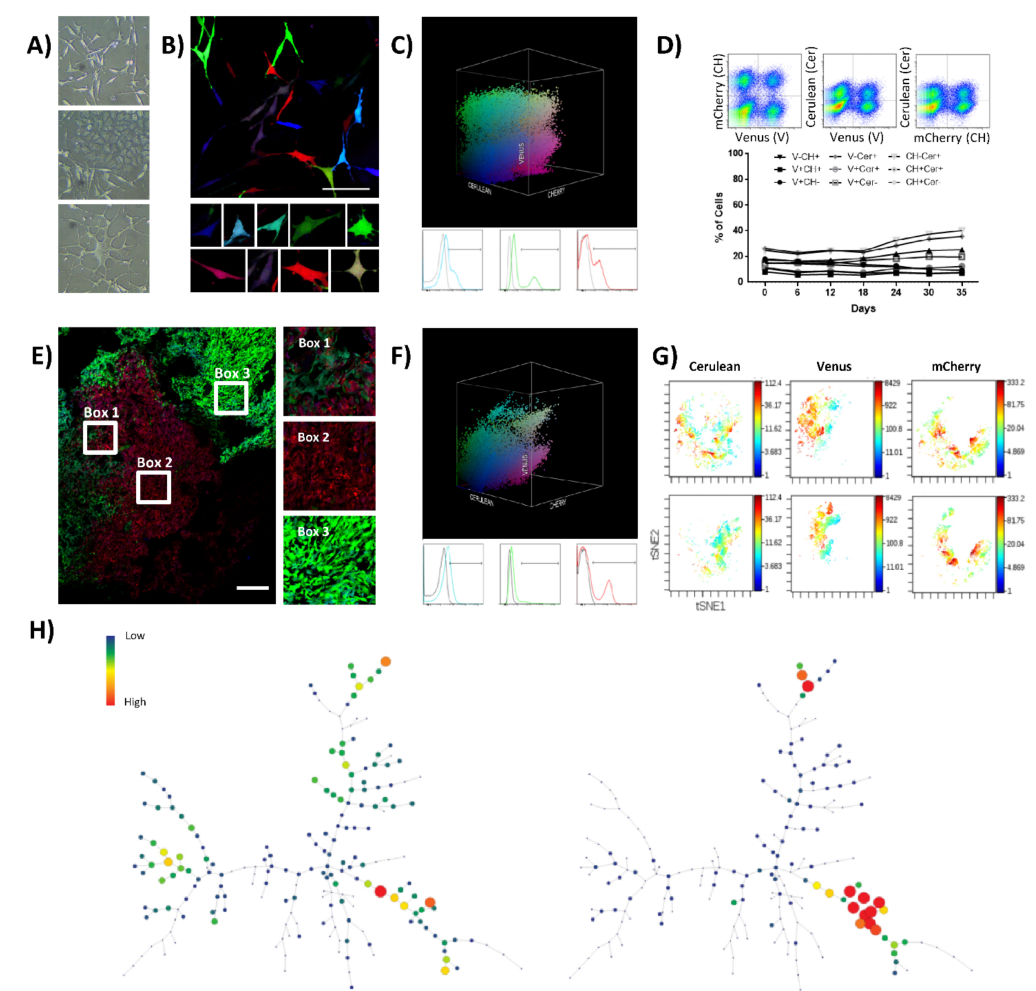
Figure 1. K5 OSA RGB cells develop oligoclonal tumors in vivo. ( A ) Phase-contrast microscopy images of K5 OSA cells; from the top to the bottom, representative images of cells with fibroblastic, tile-osteoblastic and multinucleated cell morphology during in vitro culturing. ( B ) Representative confocal microscopy images of K5-RGB cells in vitro; in the lower part, a detailed picture series of marked cells. Note that RGB-marking induces a highly variable colorimetric fluorescent marking; white bar = 100 µ m. ( C ) Three-dimensional flow cytometry plot of K5-RGB cells in vitro; the three dimensions of the 3D dot plot represent the three RGB fluorescent variants: Cerulean, Venus and mCherry. Dots are colored according to their fluorescent marker expression or their possible combinations. In the lower part, histograms showing transduced cells vs. control (un-transduced K5 OSA cells); fluorescent marker signal distribution is presented separately in blue (Cerulean), green (Venus), and red (mCherry). For detailed MOI calculation and RGB-marking optimization, see Figure S1 and Table S1. ( D ) Fluorescent marker quantification of K5-RGB cells during 35 days of in vitro culture. In the upper part, the gating strategy is presented; the percentage of cells was quantified according to the 9 possible combinations of two fluorescent markers per time: Cerulean (Cer), Venus (V), and mCherry (CH). Statistical analysis indicated no correlation between population frequencies and day of culture. ( E ) Representative confocal microscopy image of K5-RGB tumors, note the clonal patches of colors. Detailed images are presented on the right; white bars = 250 µ m. ( F ) Three-dimensional flow cytometry dot plot representation of explanted K5 RGB tumor cells. The three-dimensional dot plot is organized according to the three RGB fluorescent variants: Cerulean, Venus and mCherry. Dot color matches markers expression. In the lower part, histogram plots representing separately the fluorescent markers distribution. Note that clonal discrimination is difficult in histogram plots, while clonal populations are easily identified in the 3D representation. ( G ) Representative viSNE analysis of K5-RGB cells in vitro (upper part) and K5-RGB tumor cells ex vivo (lower part). The graphs show the enrichment and the loss of detection of some cell populations. In this case, the rainbow scale indicates cell frequency. ( H ) Representative SPADE analysis of K5-RGB cells in vitro (left) and K5-RGB tumor cells ex vivo (right); the picture shows the loss of detection of some populations. The complete 3D flow cytometry, viSNE and SPADE tree analyses are presented in Figure